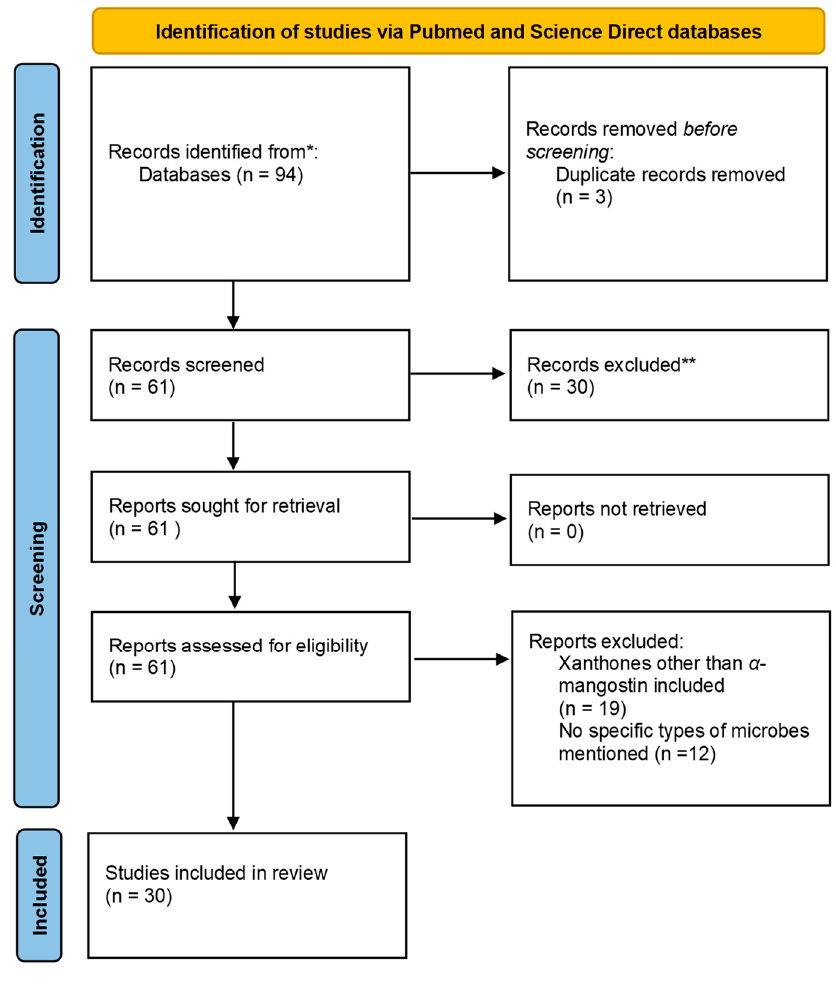
Figure 2. Flowchart demonstrating the PRISMA chart. * Records Identified; ** Records Excluded.